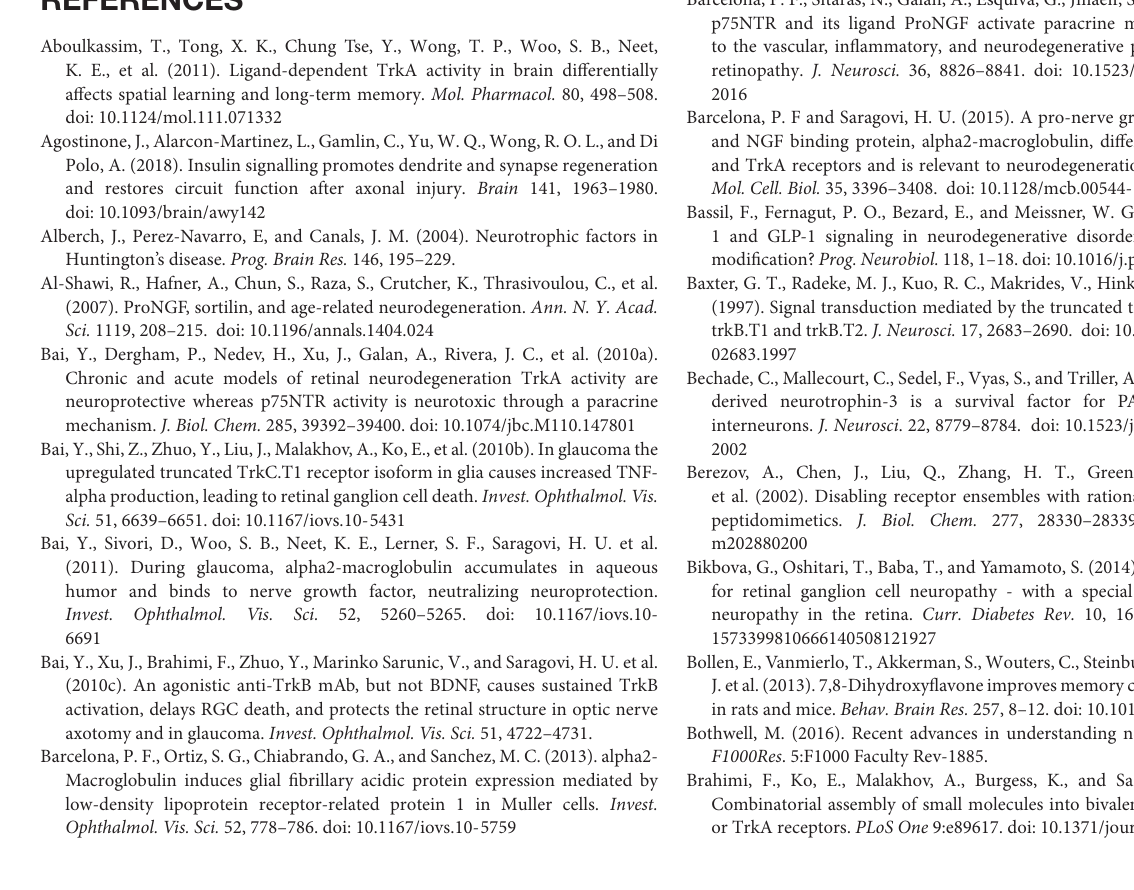
Frontiers in Cellular Neuroscience |